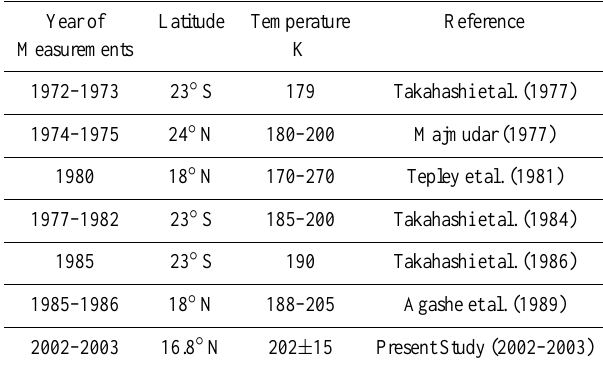
Table 2. The observed mean temperature at low-latitude stations using photometric ground-based